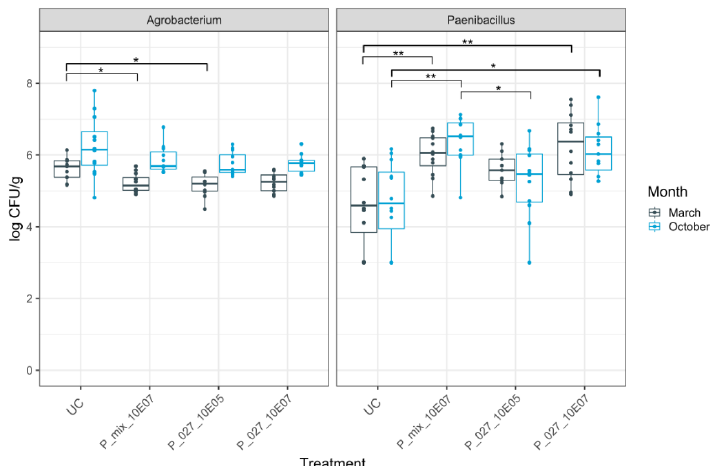
Figure 3. Population densities of rhizogenic Agrobacterium and Paenibacillus in tomato root